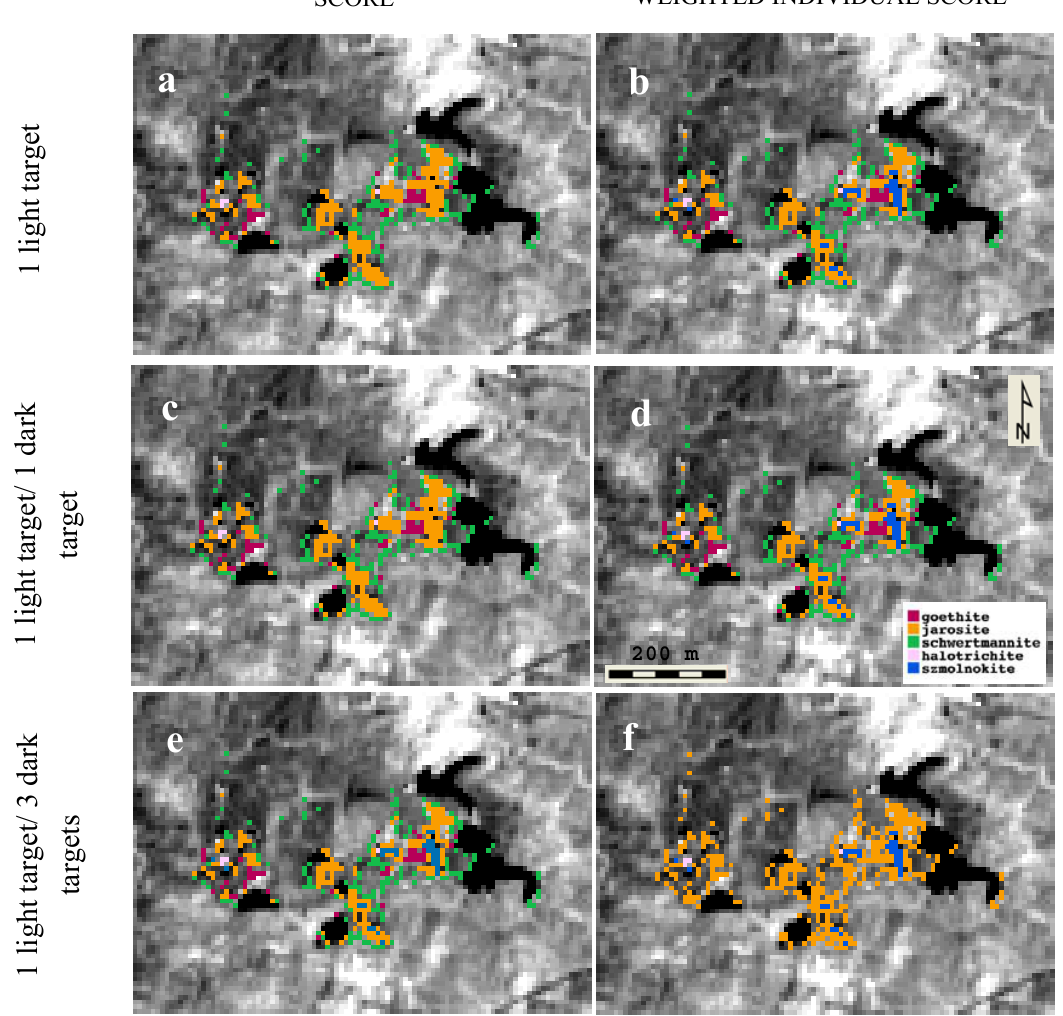
Figure 10. Maps from Hyperion data corrected with ATCOR4 on the Las Herrerias mine site from 24 August 2007, using the flat terrain mode. The legend follows the trends shown on the map built from Hymap 2009 data (Figure 5). (a) and (b) Using one light calibration target. (c) and (d) Using one light and one dark calibration targets. (e) and (f) Using one light and three dark calibration targets. (a), (c) and (e) Geological units diagnosed mineralogically with the Spectral Analyst (RSI, [35]) and the reference spectral library on pyrite weathering products (Crowley et al. , [10]), taking into account the diagnosing final score. (b) (d) and (f) Geological units diagnosed following weighted individual scores from every diagnosing algorithm (Riaza et al .,